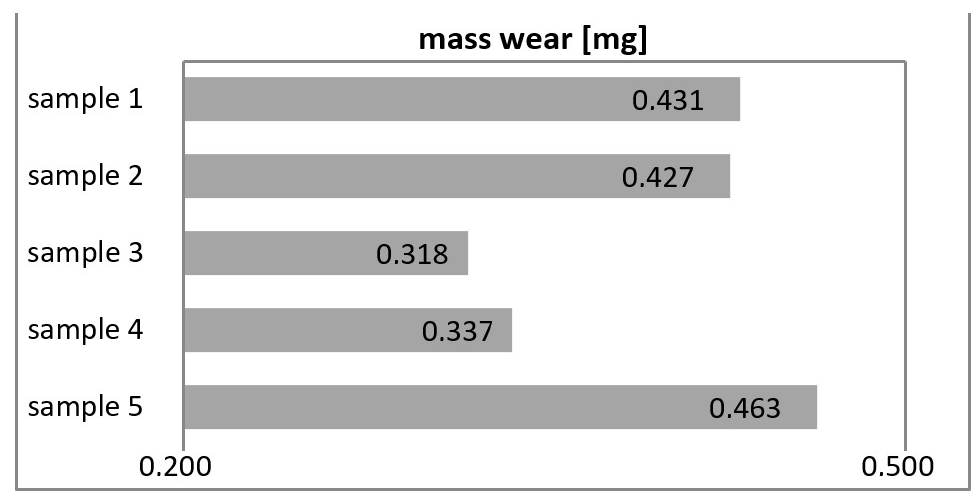
Figure 6. Mass wear of samples.